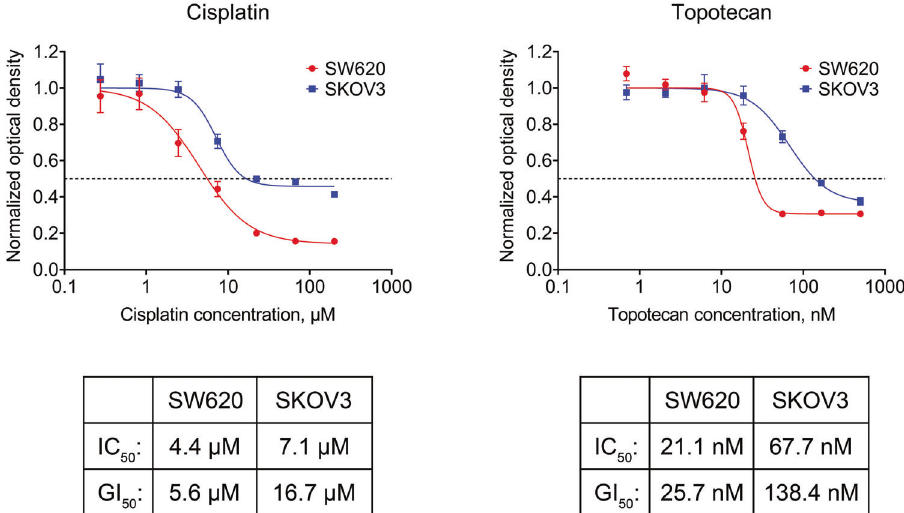
Fig. 1 Response of SW620 and SKOV3 cells to treatment with various concentrations of cisplatin or topotecan. The MTS assay values obtained from treated cells were normalized to the untreated sample. The data are presented as mean ± standard deviation ( N = 4 for cisplatin, N = 3 for topotecan). The dashed lines indicate a 50% reduction in the MTS